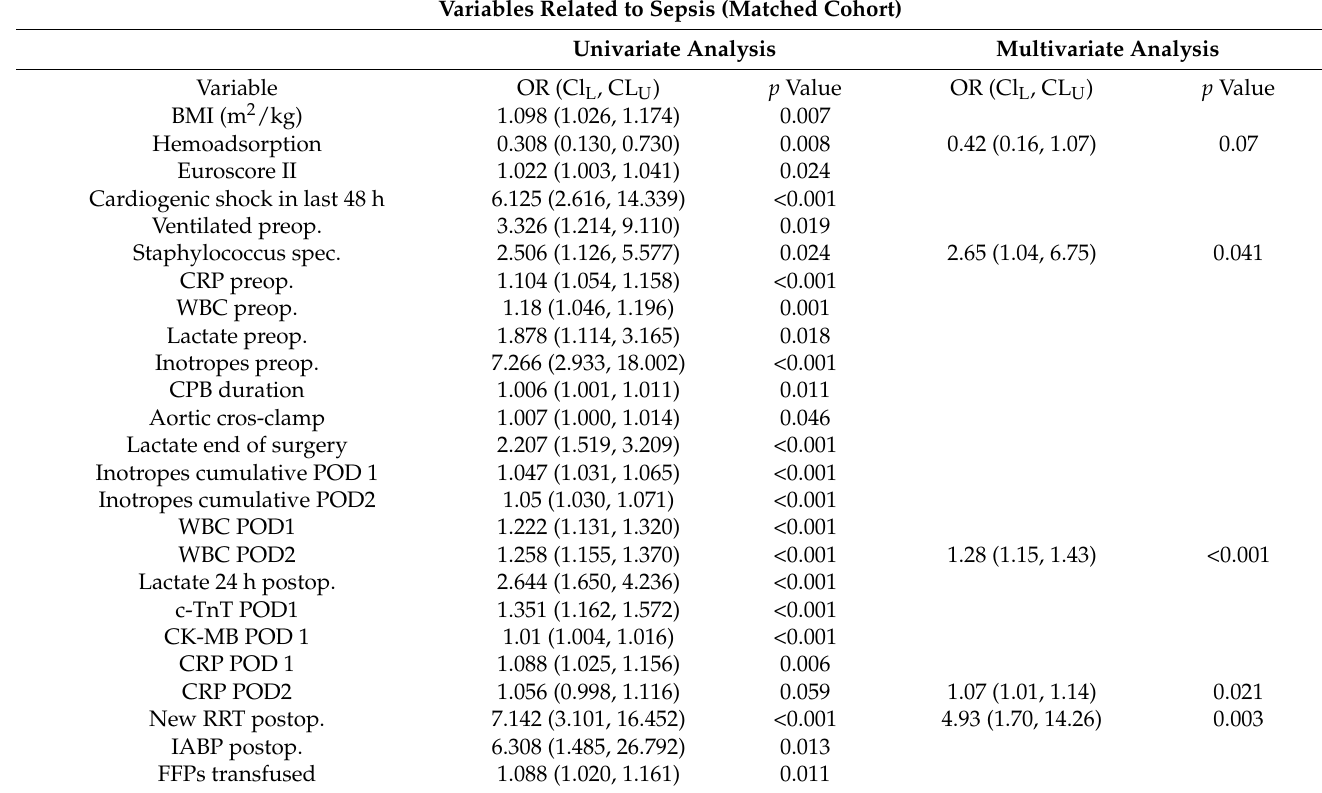
Figure 2. Basic laboratory values: C-reactive protein (mg/dL) and white blood cell counts (×10 3 /µL); POD: postoperative day; WBC: white blood cell count. 3.3. Regression Analyses for Sepsis, Sepsis-Associated Mortality and In-Hospital Mortality Table 4. Variables related to Several parameters predicted sepsis, sepsis-associated and in-hospital mortality, as